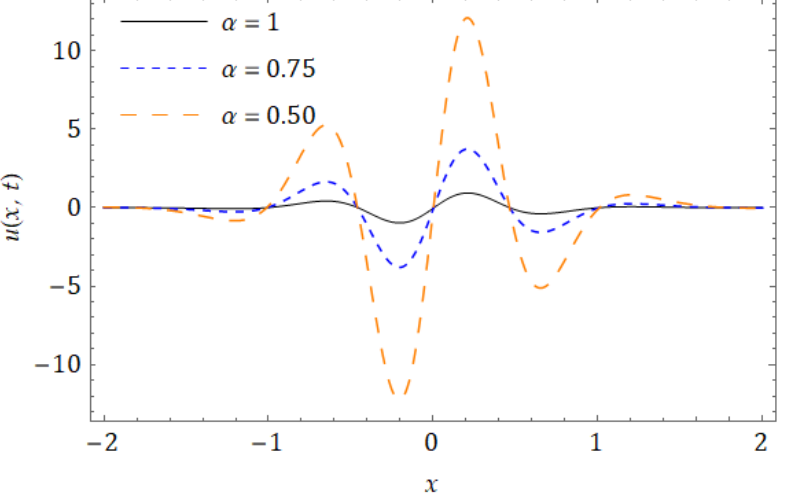
Figure 2. Response of the obtained solution with distinct 𝛼 and time at 𝑛 = 1, 𝑡 = 0.5, ℏ = −1, 𝛽 = 1, 𝑐 = −1, 𝜅 = 1 and 𝜌 = 0.001 for Case I.